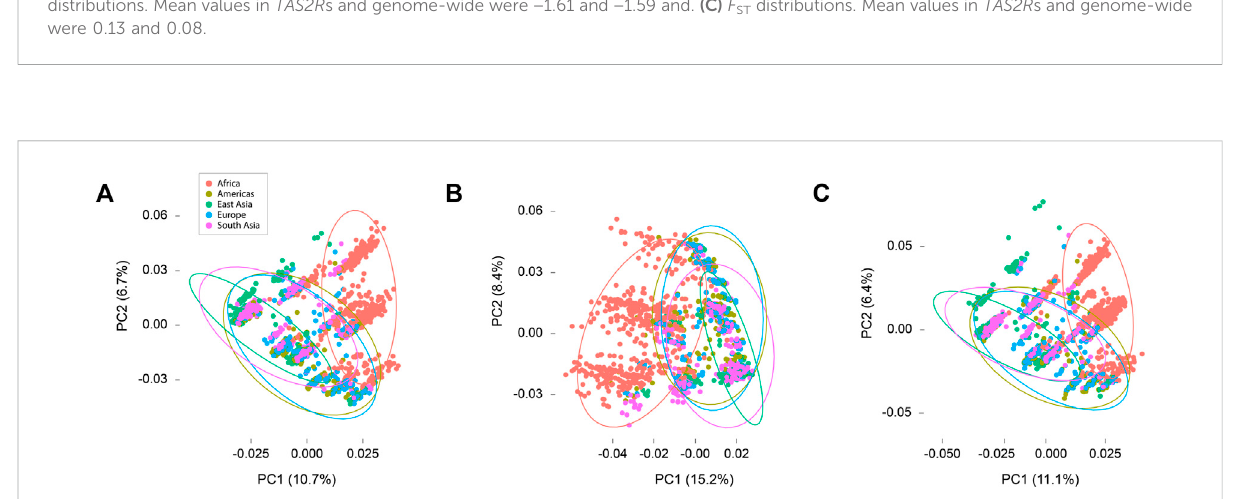
FIGURE 3 Principal components plots. (A) All sites. (B) Synonymous sites only. (C) Nonsynonymous sites